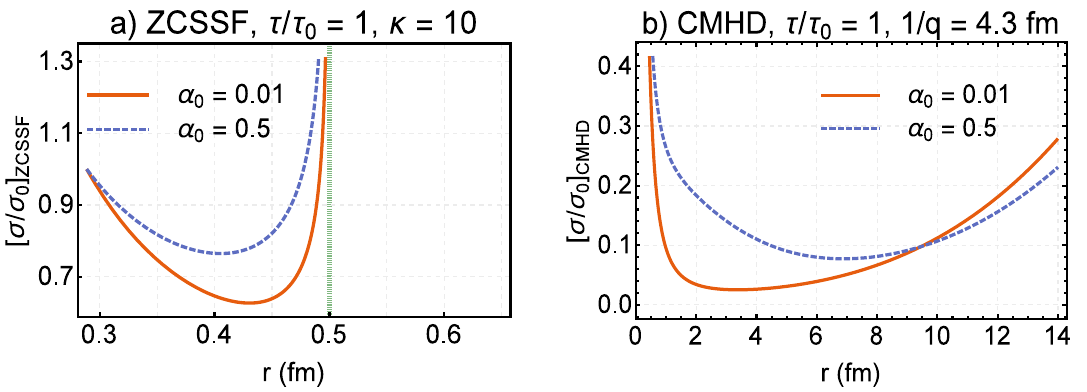
Figure 9 . (color online). The r dependence of [ σ/σ 0 ] for the ZCSSF solution (panel a) and the CMHD solution (panel b) is plotted at τ = τ 0 and for α 0 = 0 . 01 (solid orange curves) and α 0 = 0 . 5 (dashed blue curves). For the CMHD solution q is chosen to be q = 1 / 4 . 3 fm − 1 . The parameter κ , appearing in the EOS ǫ = κp is chosen to be κ = 10 for the ZCSSF and κ = 3 for the CMHD solution. The validity borderline for the ZCSSF solution at τ = r is demonstrated by a vertical green line. Both [ σ/σ 0 ] ZCSSF and [ σ/σ 0 ] CMHD decrease with increasing r at early stages after the collision, and then, after passing a minimum, they increase with increasing r . Different choices for α 0 significantly affect the evolution of σ/σ 0